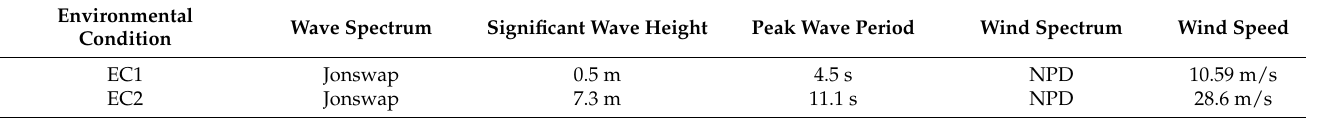
Figure 7. Image of the combined 15 MW FOWT numerical model.